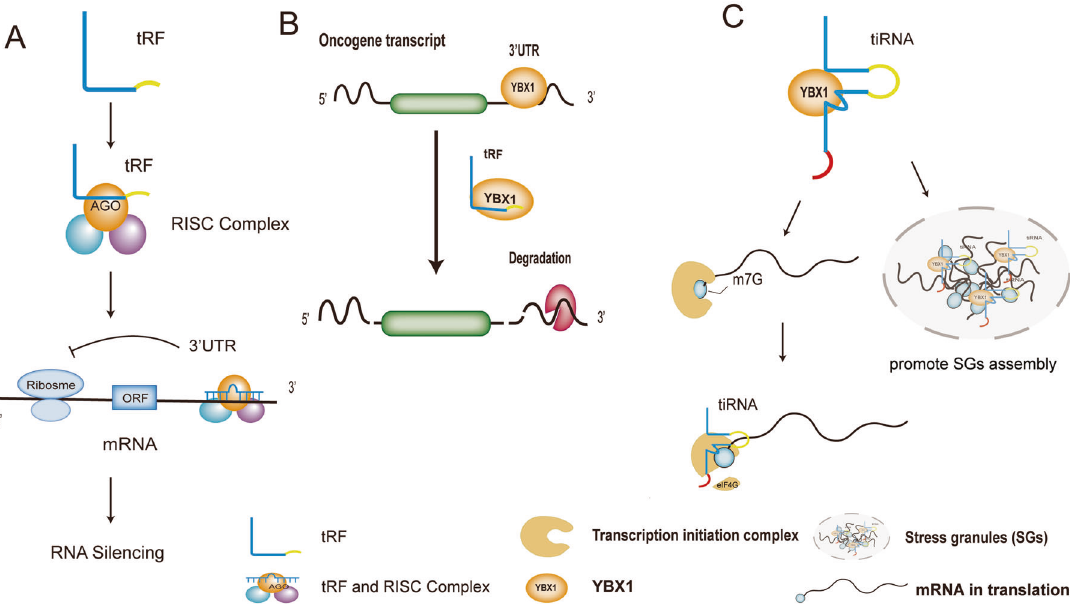
Fig. 3 Action mechanisms of tsRNAs. A tRF binds AGO proteins to form the RISC complex. The complex performs a miRNA-like action, binding to the 3 ’ UTR of the target gene transcript through incomplete complementary and suppressing the expression levels of the gene. B tRF competes with the oncogene transcript to bind YBX1, resulting in the degradation of the oncogene transcript. C tiRNAs and YBX1 synergize to prevent eIF4G/A from initiating the translation and promote the SGs